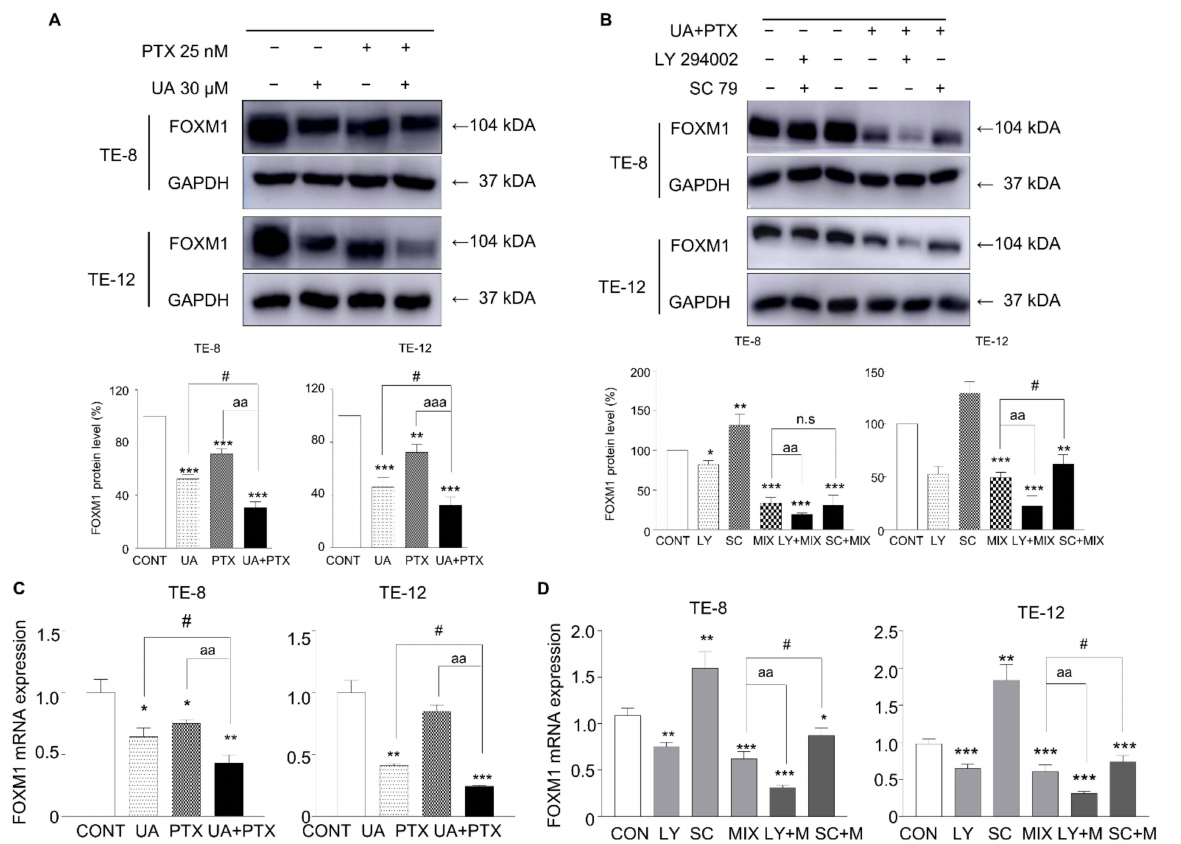
Figure 6. UA and PTX inhibited FOXM1 expression in ESCC cells. ( A , B ) Protein expression of FOXM1 was detected by western blotting. ( C , D ) mRNA levels of FOXM1 were measured by real-time PCR and analyzed by the ∆∆ ct method. GAPDH is the internal control. Quantification of bands was calculated using Image J. Data are expressed as the mean ± SE. *, compared with the control group; # , UA compared with the UA plus PTX combination group; a , PTX group compared with the UA plus PTX combination group. # , * p < 0.05; aa , ** p < 0.01 and aaa , *** p < 0.001. CONT, control; LY, LY294002; SC, SC79; MIX, combination treatment of ursolic acid 30 µ M and paclitaxel 25 nM; UA, ursolic acid 30 µ M; PTX, paclitaxel 25